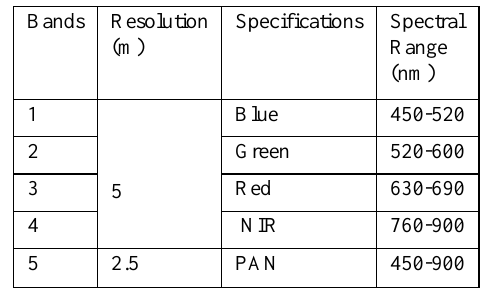
Table 1. Specifications of LANDSAT-8 (Landsat-8, 2017).